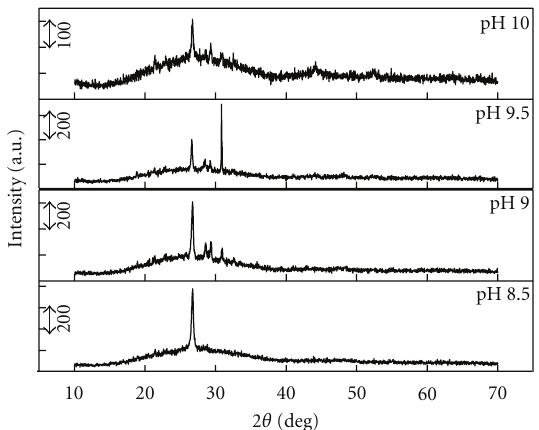
Figure 1: XRD patterns of Cd 1 − x Zn x S thin films prepared at di ff erent pH